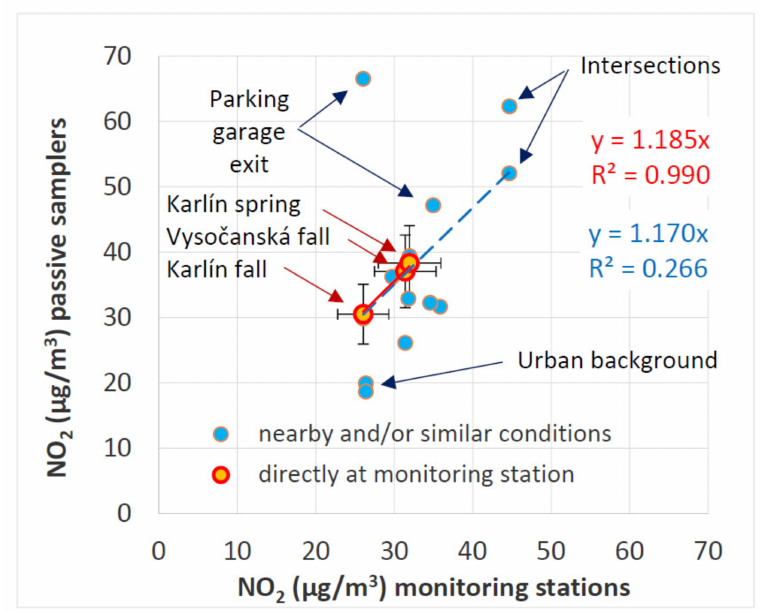
Figure 2. Comparison of passive sampler reported NO 2 concentrations to the corresponding average values from corresponding monitoring stations. Larger points circled in red denote the colocation of the sampler at the monitoring